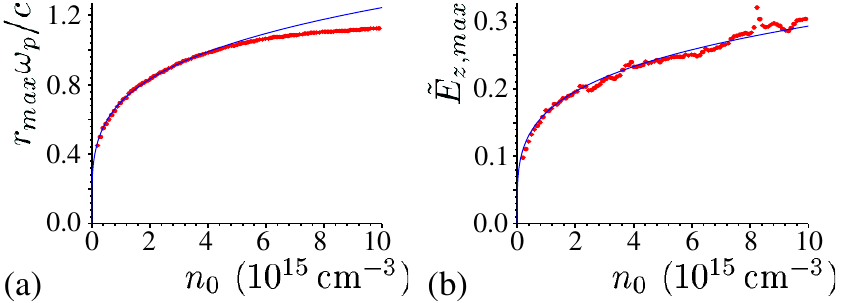
FIG. 6. (Color) Plasma density dependence of the maximum bubble radius (a) and maximum decelerating field (b) at the early stage of beam-plasma interaction. Dots show numerically obtained values, curves are obtained from formulas (11) and (17).